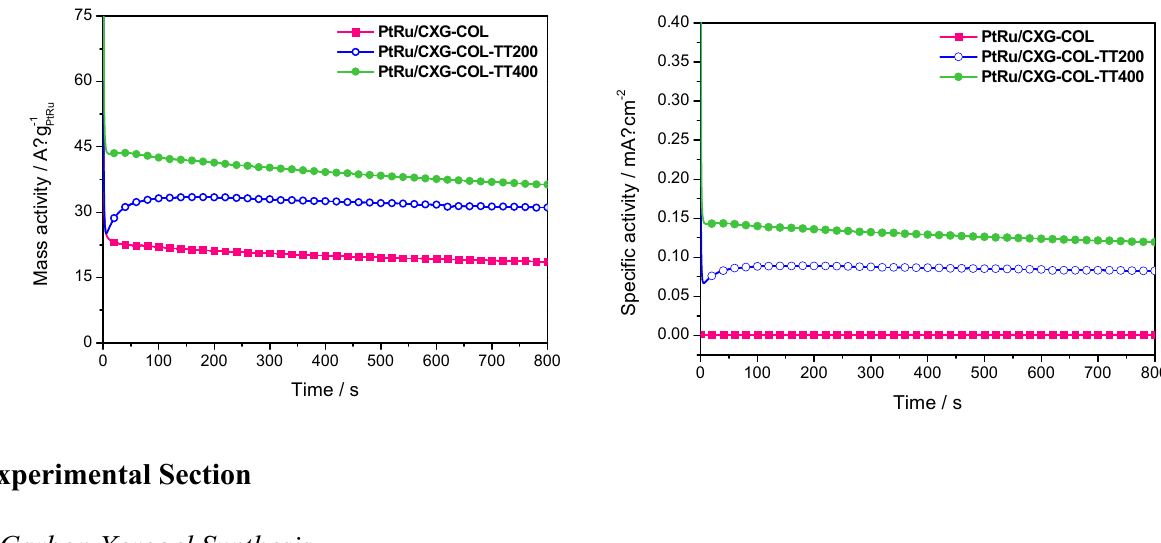
Figure 5. Current density vs. time curves recorded in a 2 M CH solution at room temperature for the PtRu carbon-supported catalysts at E = 0.60 V vs.